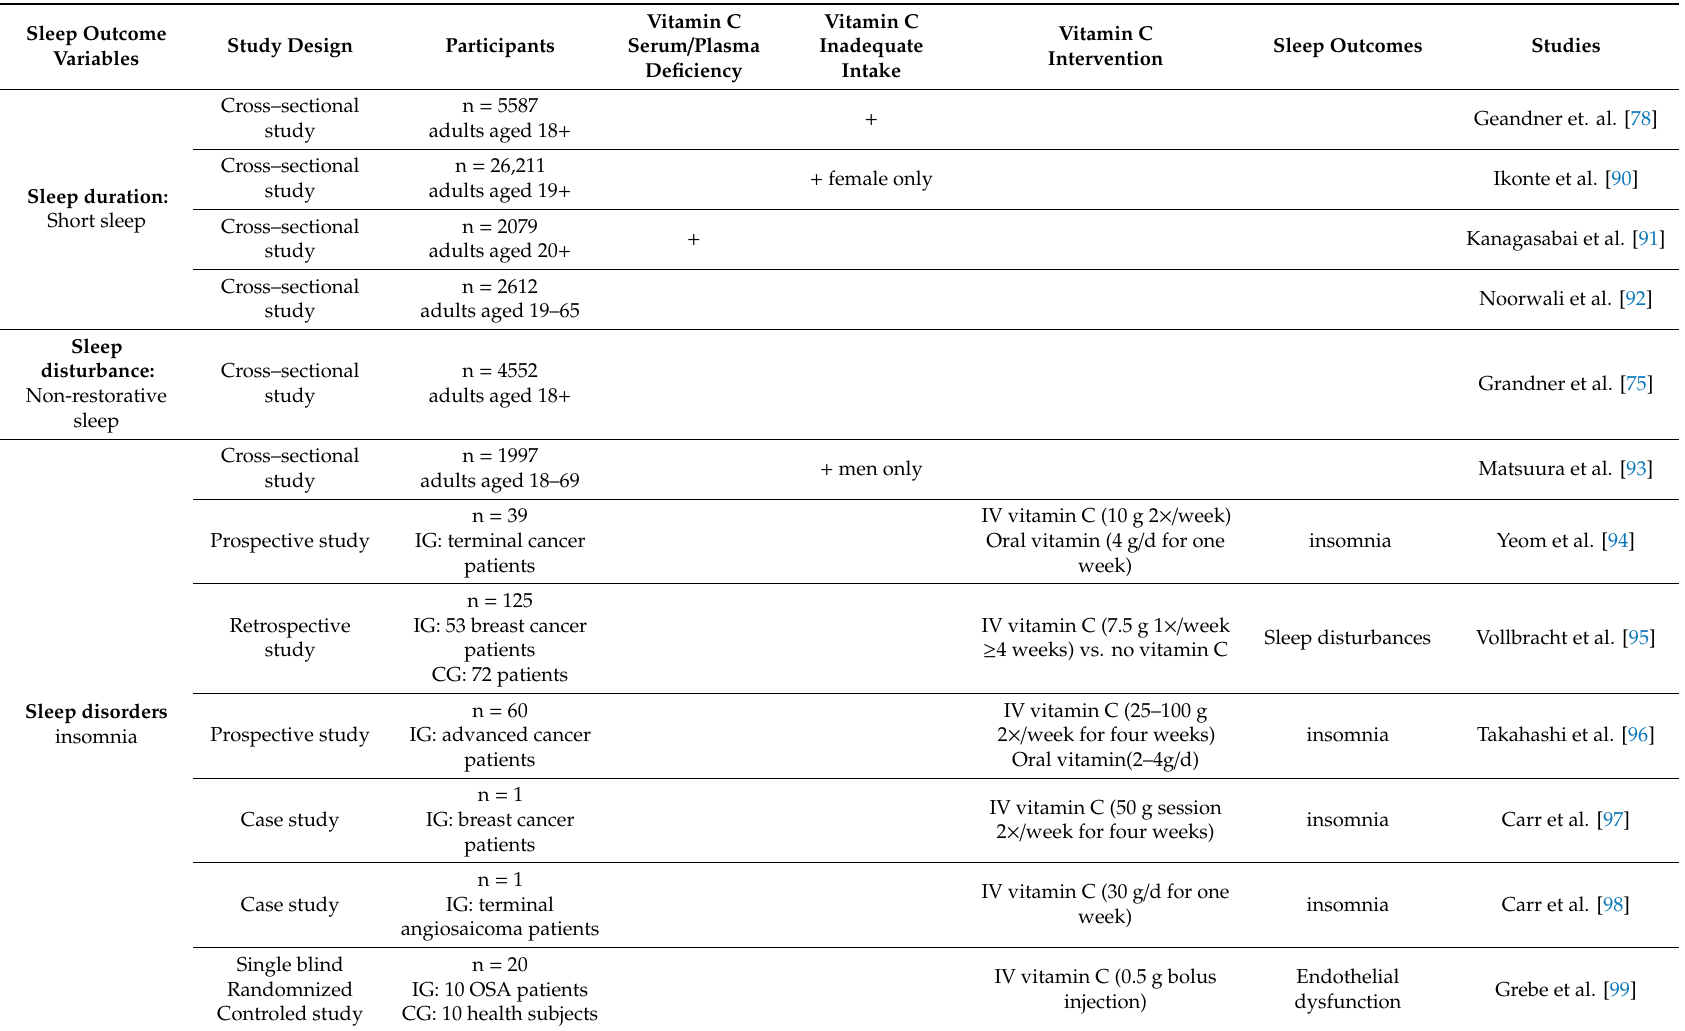
Table 3. Example of studies linking vitamin C and sleep